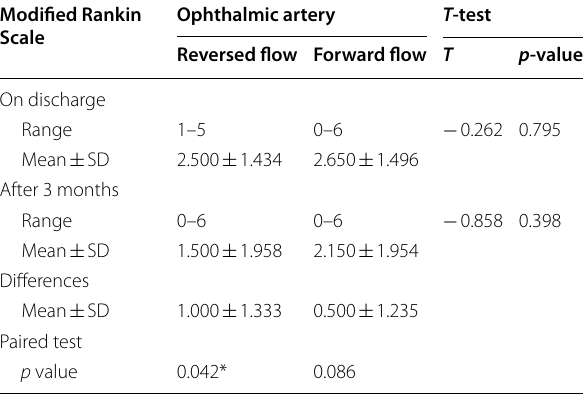
MRS: Modified Rankin Scale, p value < 0.05 is considered statistically